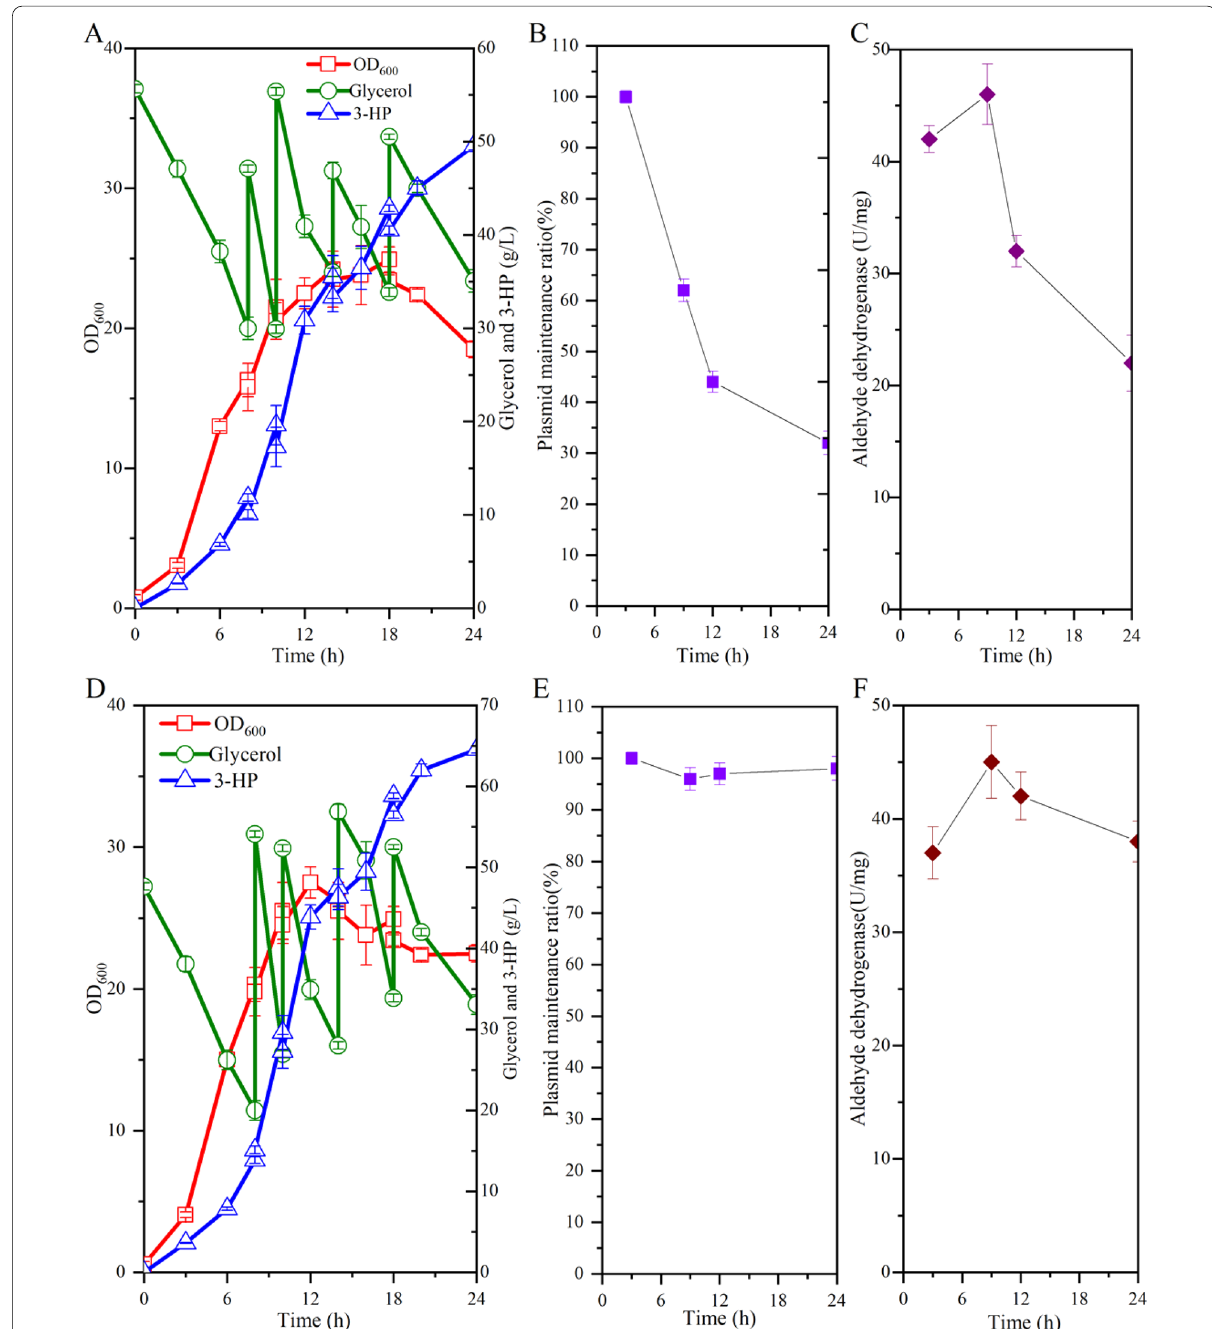
Fig. 6 Production of 3-HP by strain VN14 and strain VN15 (with a plasmid maintenance system) during fed-batch fermentation. A Fermentation profiles of strain VN14; B Plasmid maintenance ratio by strain VN14; C Activity of aldehyde dehydrogenase of strain VN14; D Fermentation profiles of strain VN15; E Plasmid maintenance ratio by strain VN15; F Activity of aldehyde dehydrogenase of strain VN15. 100 mg/L of ampicillin was added during the fermentation of strain VN14, while no antibiotics were added during the fermentation of strain